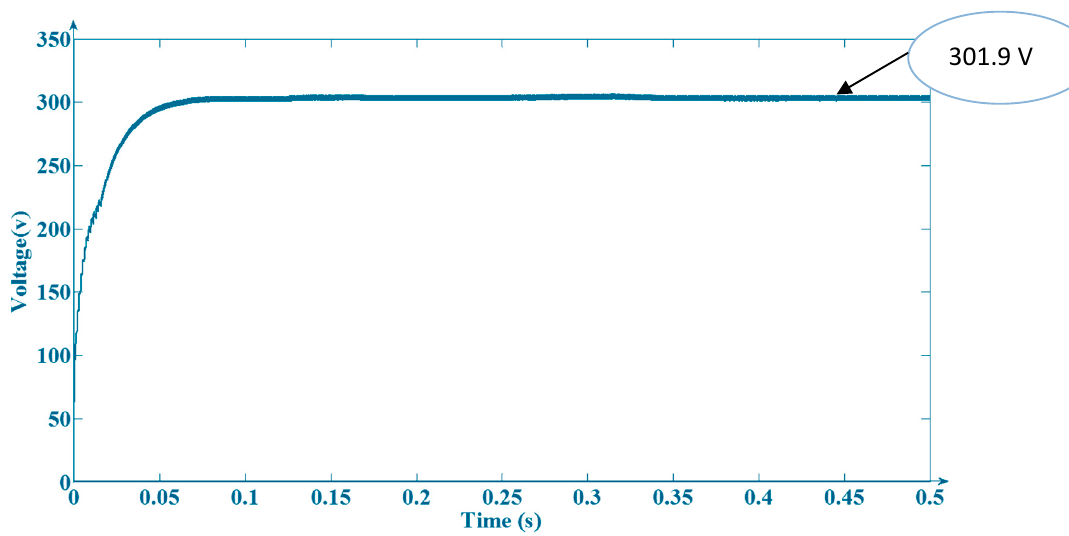
Figure 52. Output voltage waveform for hybrid controller-4-based BDC.